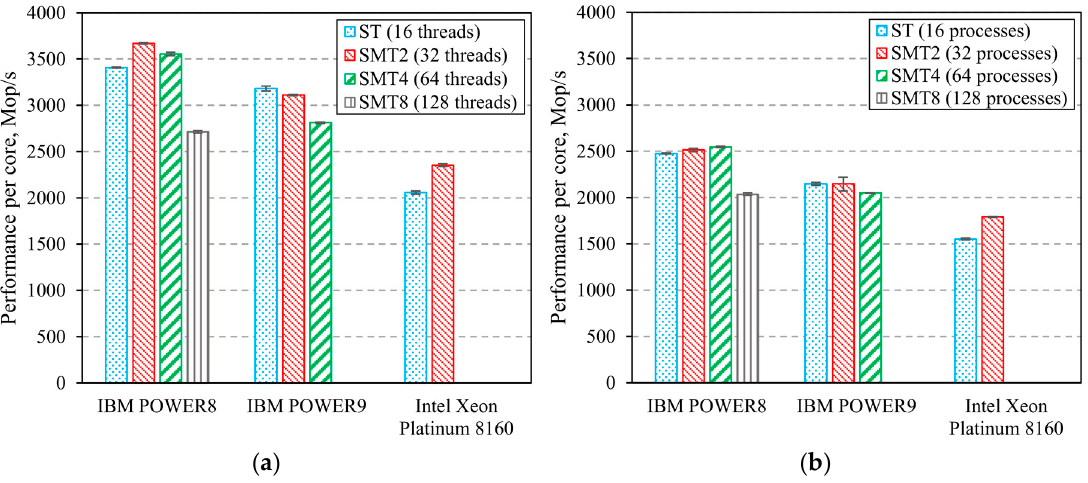
Figure 8. FT benchmark results: OpenMP version ( a ) and MPI version ( b ).